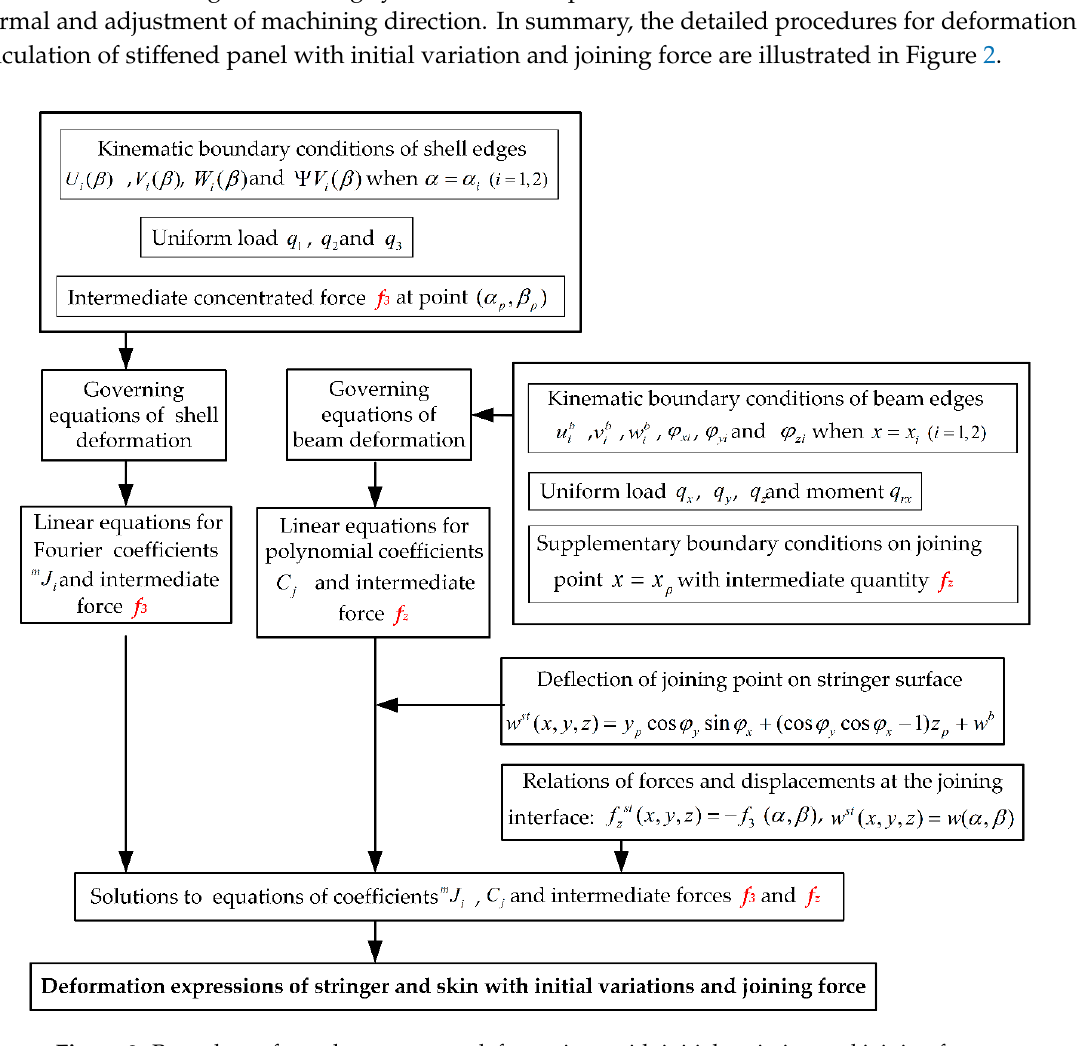
Figure 2. Procedure of panel components deformations with initial variation and joining force.